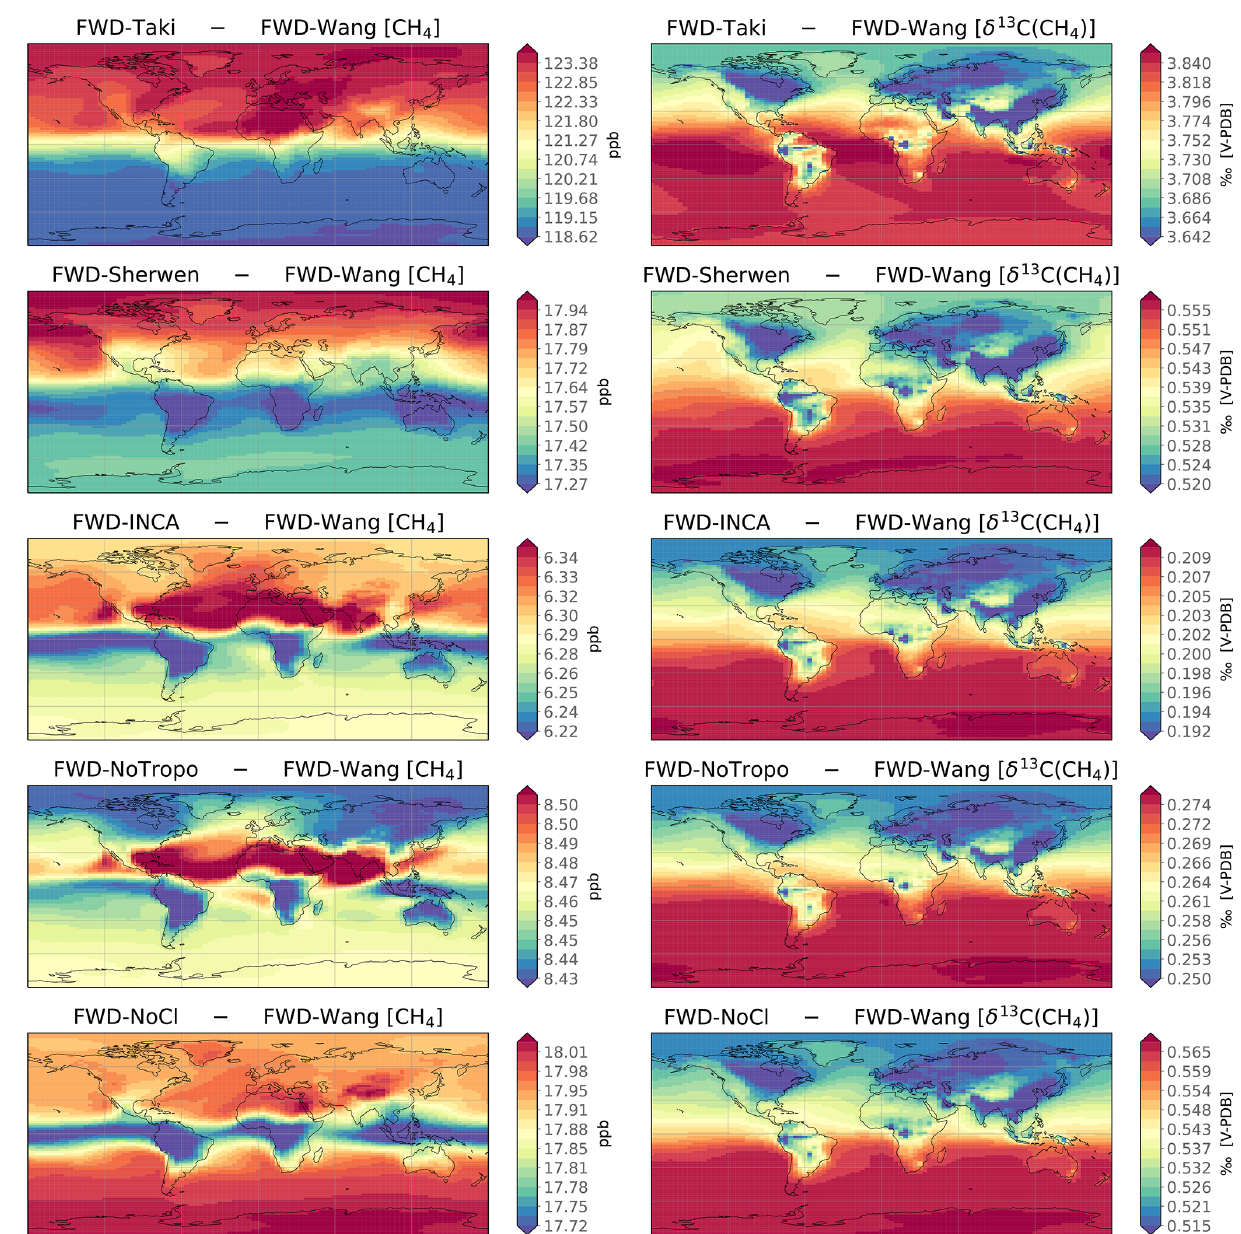
Figure 2. Surface absolute bias between FWD- ∗ and FWD-Wang simulations averaged over 2010–2018. Temporal averaging is performed before substraction. The left column displays the biases between the CH 4 mole fractions. The right column shows the biases between the δ 13 C(CH 4 ) values. Note that the scales are different for each